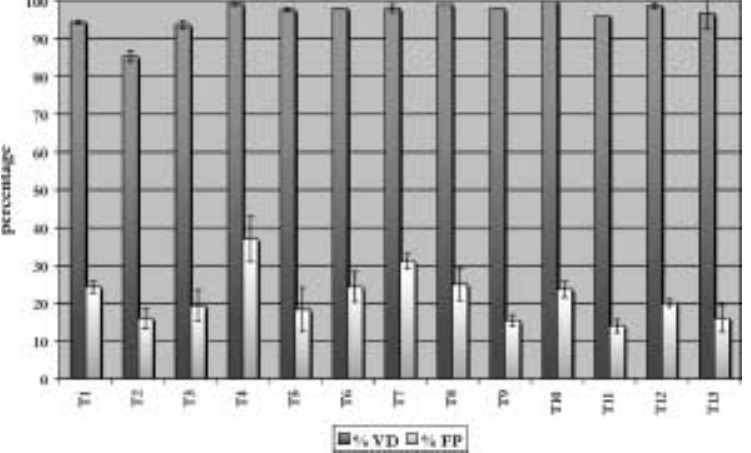
Fig. 5. Percentages of well-detected vessels (%VD) and of false-positive structures (%FP) on scanner image, by reference with interactive identification. Vessels were classically immunostained using DAB as chromogen (series 1).